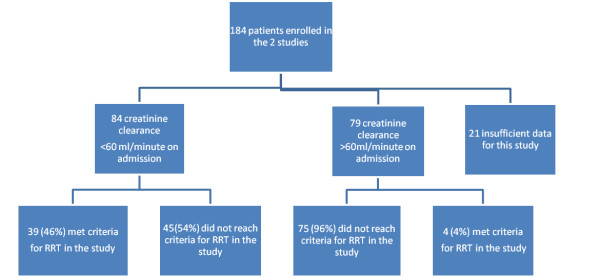
Overview of the patients.